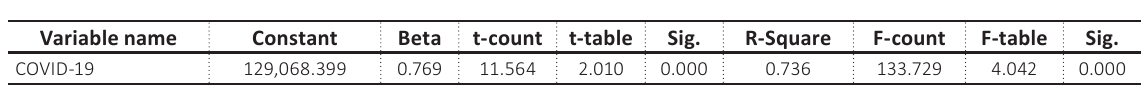
Table 4. SPSS simple regression output